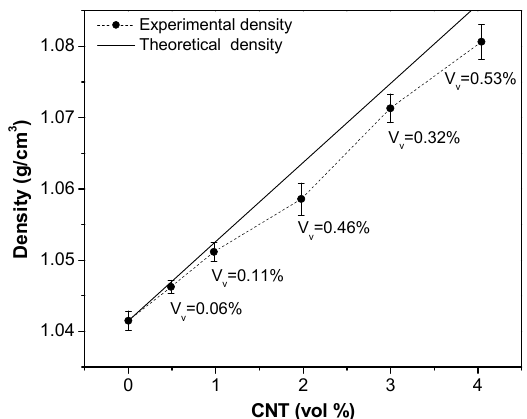
Figure 3. Experimental density values of ABS-CNT nanocomposite compared to theoretical density and voids fraction ( V v ).